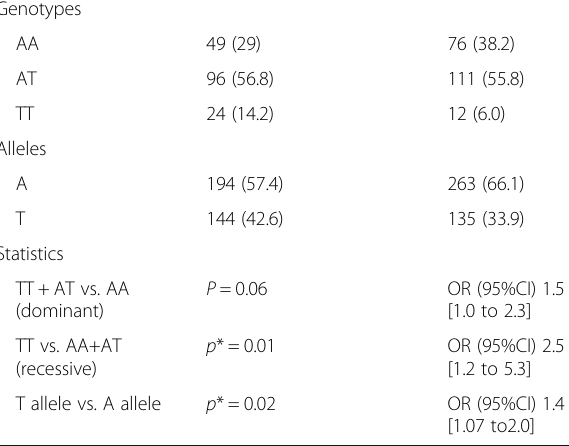
Table 4 Genotype frequencies of INF- γ + 874 A/T in different species of leishmaniasis and healthy human controls